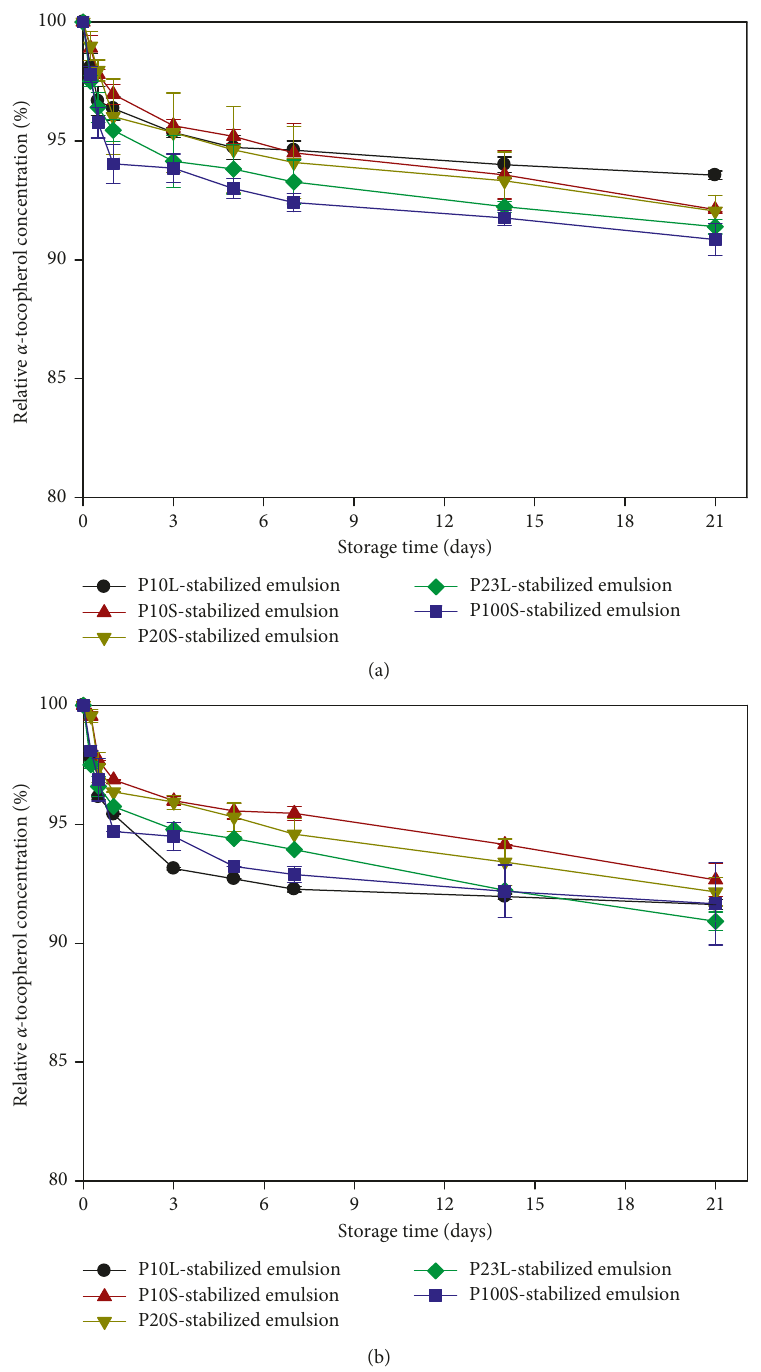
Figure 2: Change in concentration of α -tocopherol in emulsions at pH 7 (a) and 3 (b) stored at 25 ° C. P10L, polyoxyethylene 10 lauryl ether; P10S, polyoxyethylene 10 stearyl ether; P20S, polyoxyethylene 20 stearyl ether; P23L, polyoxyethylene 23 lauryl ether; P100S, polyoxy- ethylene 100 stearyl